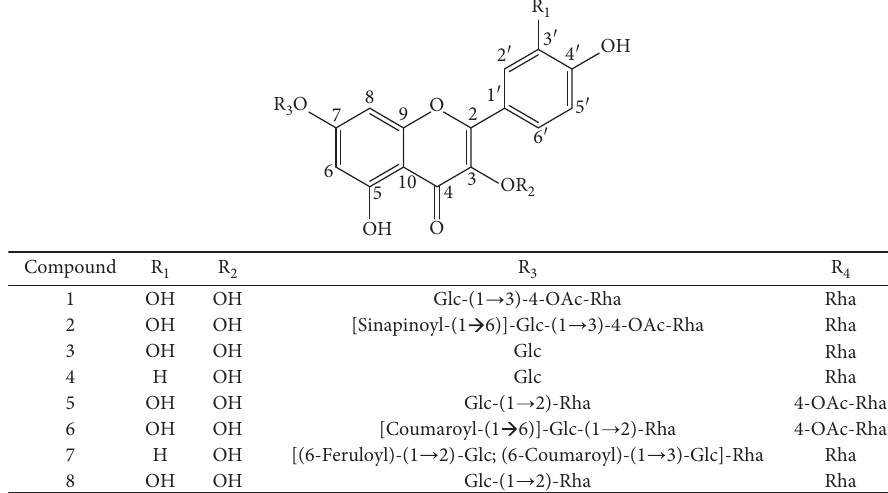
Figure 2: Structure of isolated flavonoids 1–8. Table 4: The cytotoxicity using HepG2 of isolated compounds